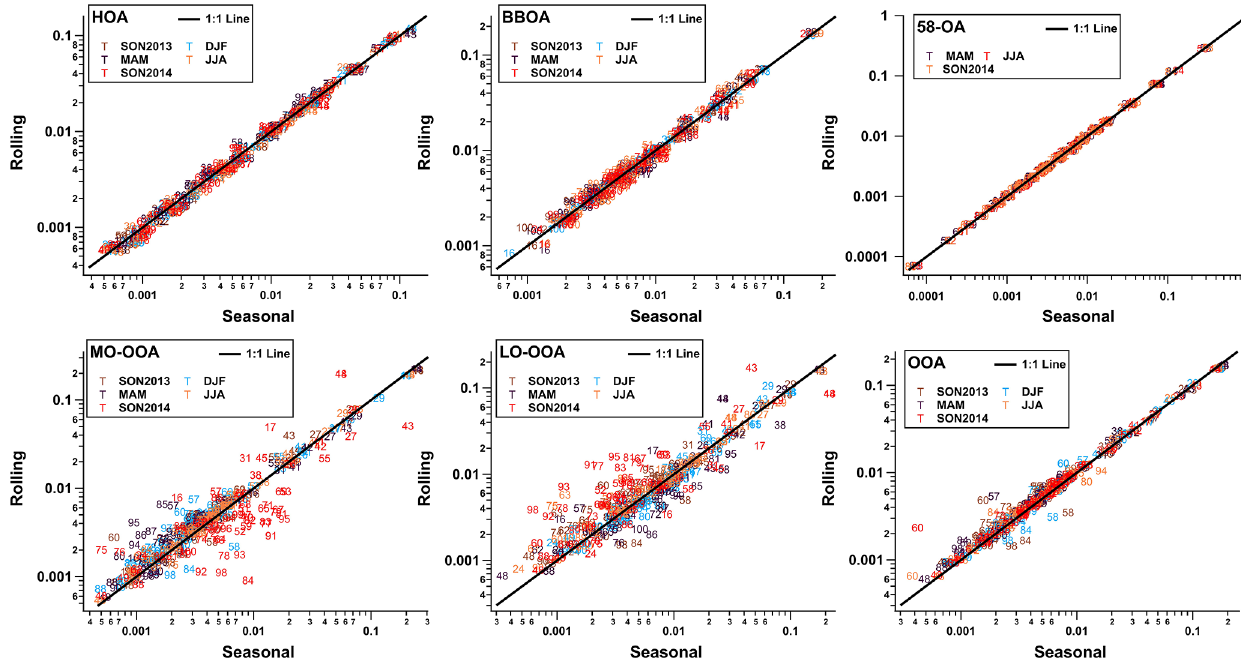
Figure A2. Profile comparisons between rolling results and seasonal results for each factor (log scale).